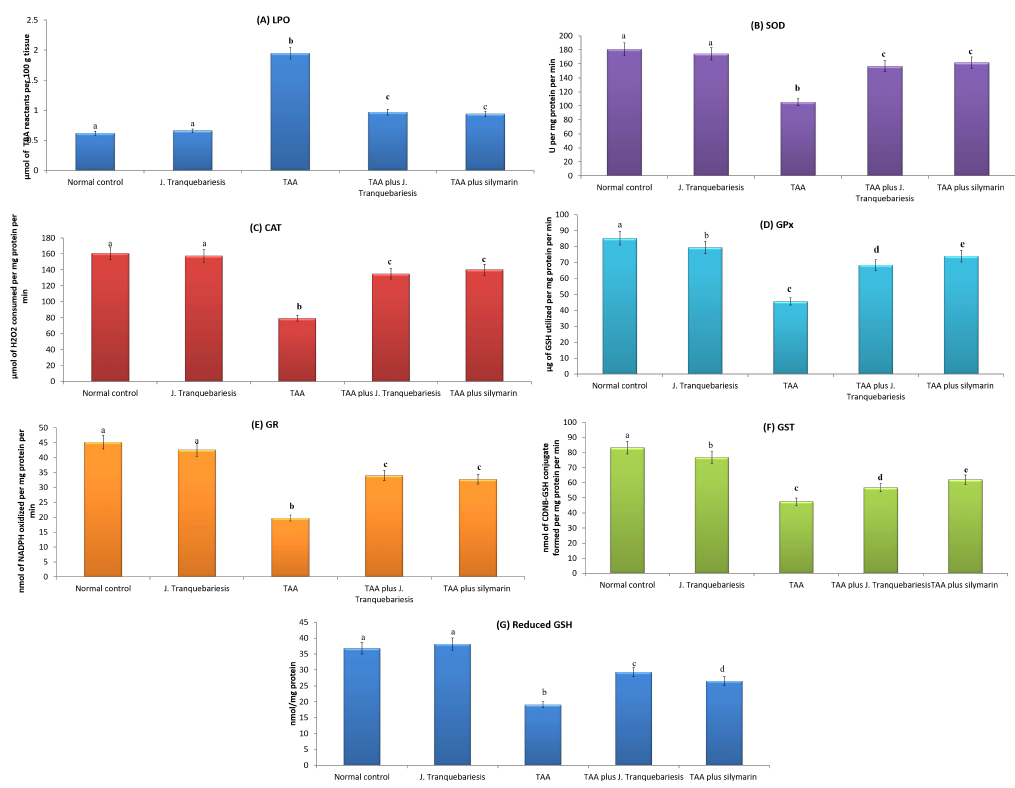
Figure 2. ( A – G ) Effects of Justicia tranquebariesis L. on liver lipid peroxidation and antioxidant enzyme activities in TAA intoxicated rats. Values are expressed as mean ± S.D. for six animals in each group. Values not sharing a common superscript (a–e) differ significantly. Letter “a” is significant to b, c, d, and e; likewise the letter “b” is significant to a, c, d and e. LPO—lipid peroxidation;